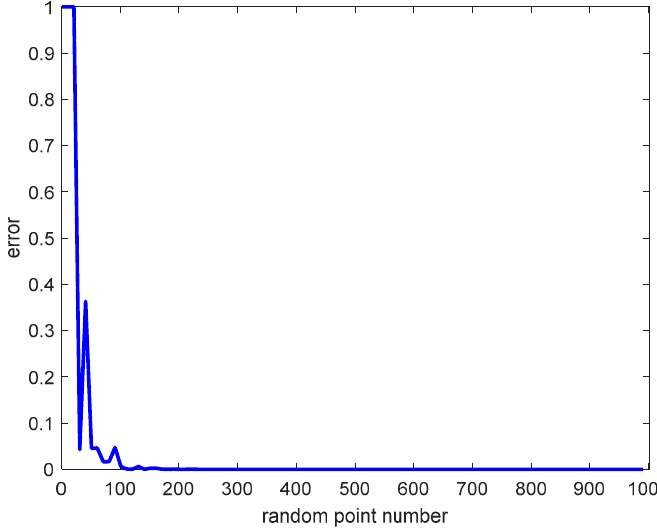
∩ C ( 0, v max ) = Φ ; ( b ) ORCV τ A